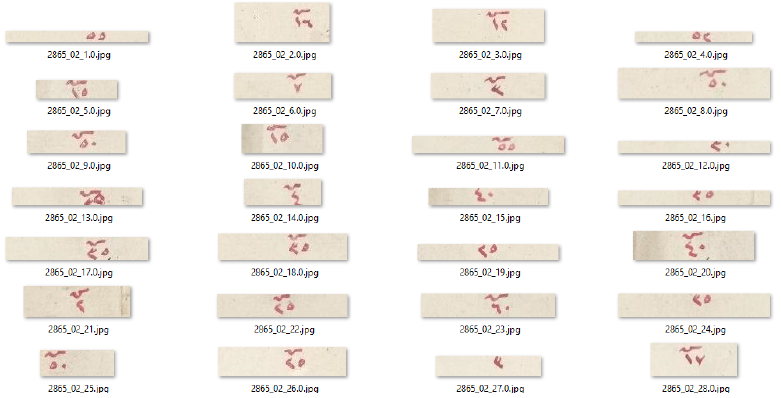
Figure 4. A subset of automatically cropped ages are